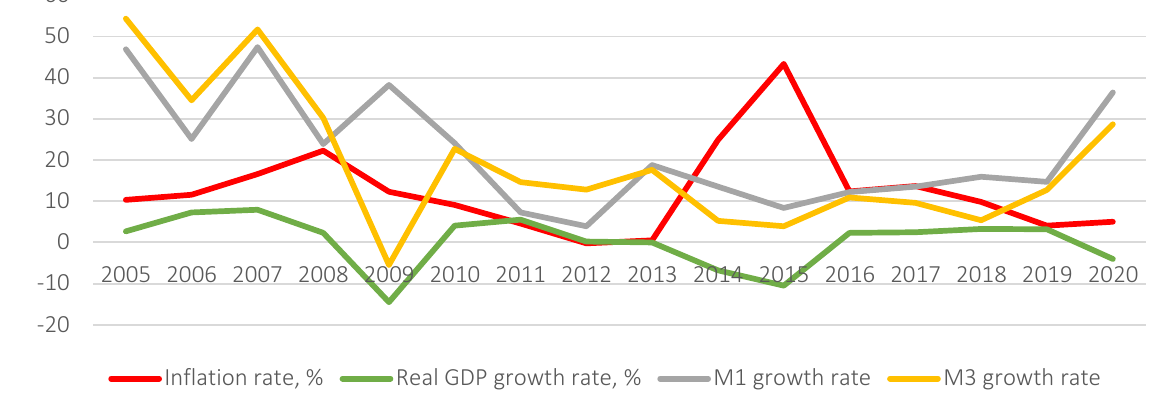
Figure 5. Values of indicators characterizing the features of the MTM monetary